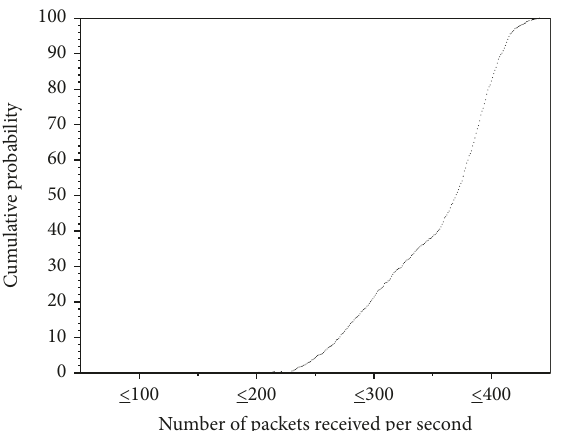
Figure 6: The cumulative probability of number of packets re- ceived per second by each vehicle.